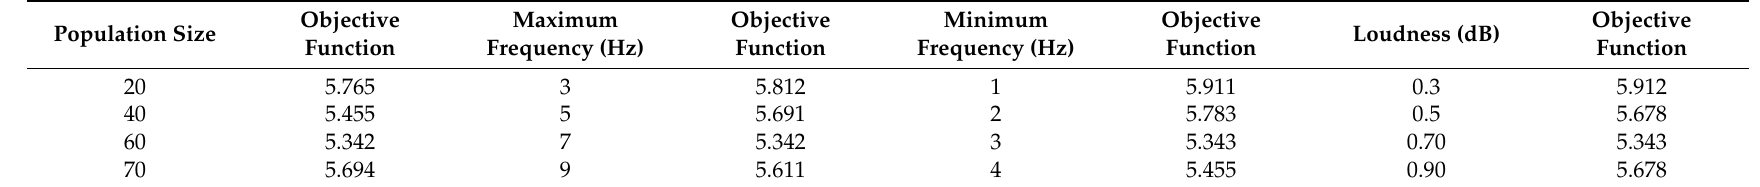
Table 3. Sensitivity analysis for